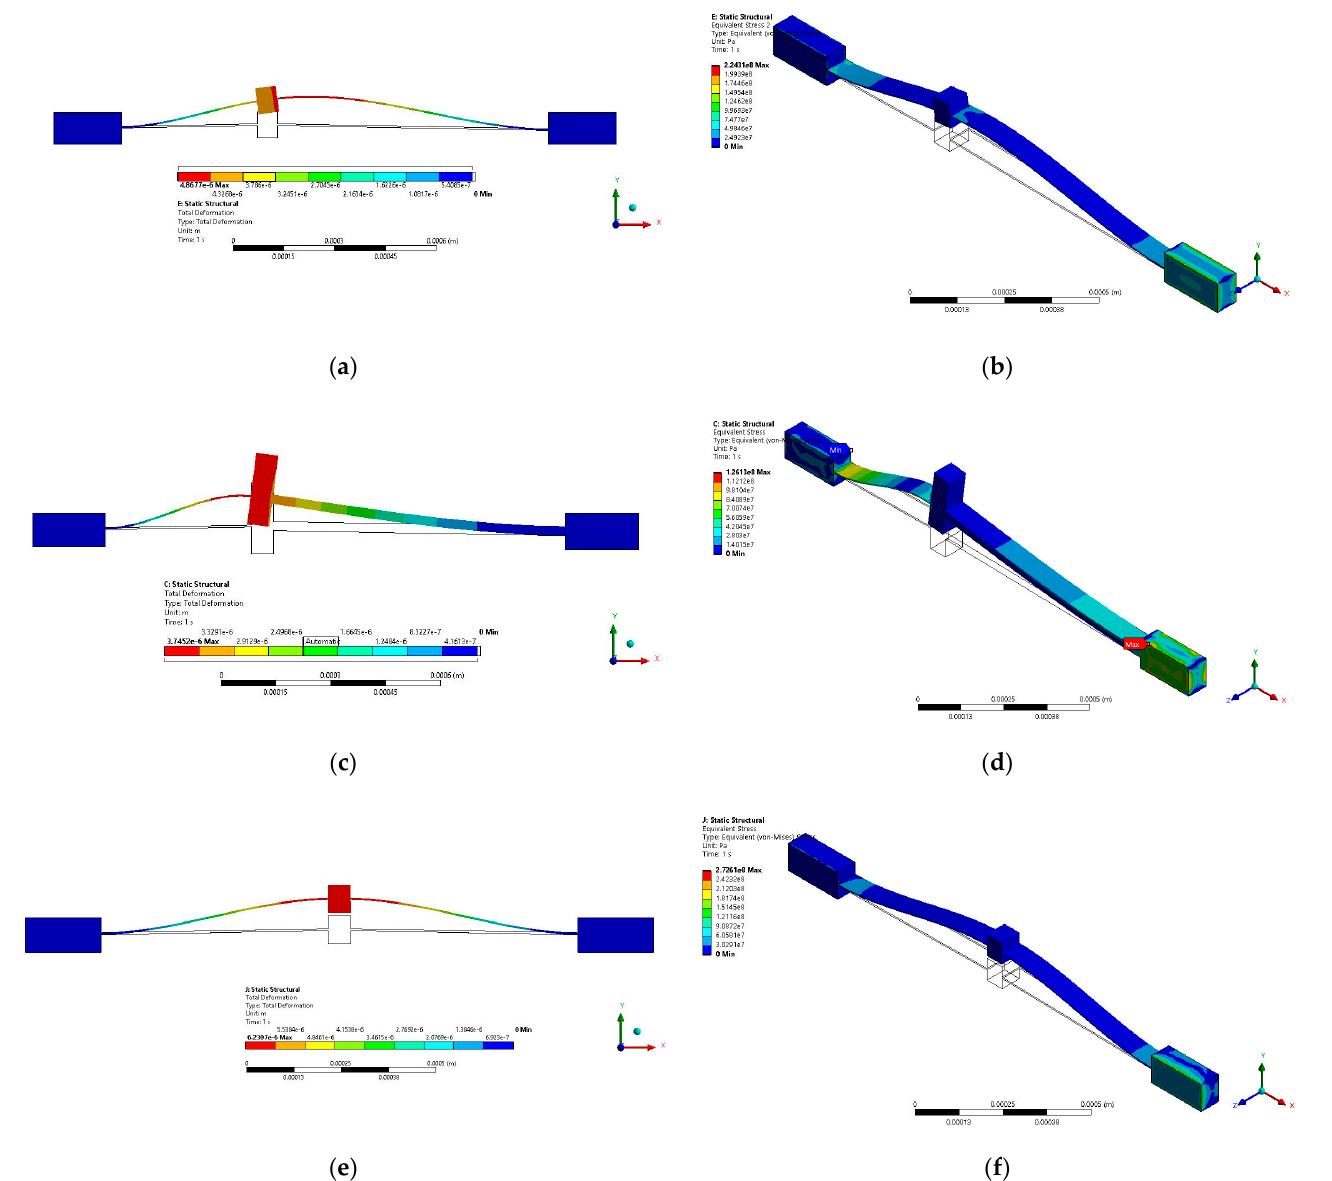
Figure 6. Simulation results of ( a ) deformation and ( b ) equivalent von Mises stress of microactuator 1. ( c ) Deformation and ( d ) equivalent von Mises stress of microactuator 2. ( e ) Deformation and ( f ) equivalent von Mises stress of V-shaped microactuator. The simulation results of force and equivalent von Mises stress for microactuators 1, 2, and the V-shaped microactuator are given in Figure